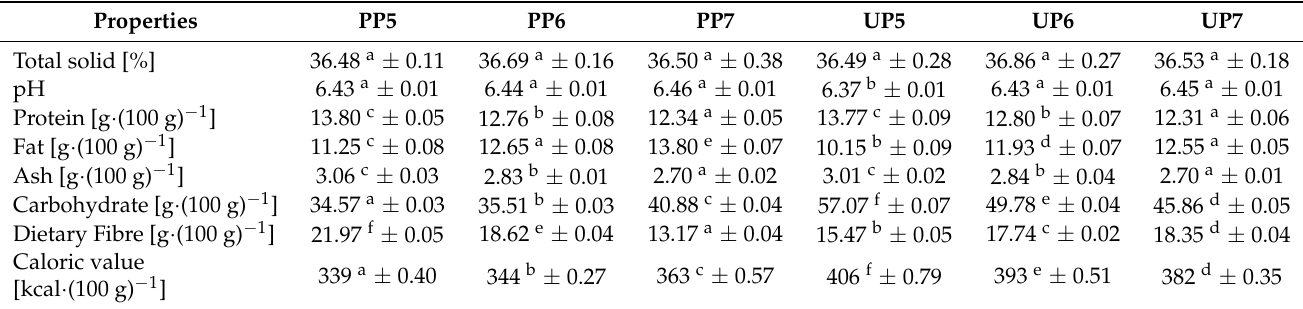
Table 2. Chemical properties and energy value of the tested ice